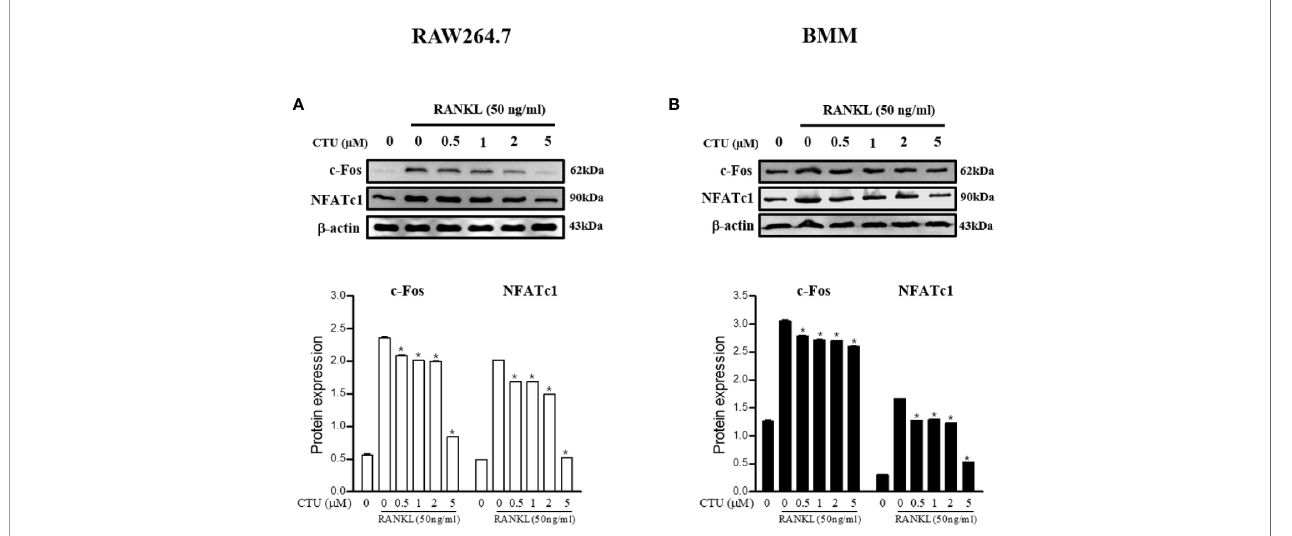
FIGURE 9 | The effects of CTU on NFATc1 and c-Fos protein expression in RANKL-induced RAW 264.7 (A) and BMM (B) cells. The cells were cultured in the presence of RANKL with the CTU. After 24 h, the total protein was isolated and the protein expression levels were evaluated by western blots.* p < 0.05 compared with the only RANKL-treated